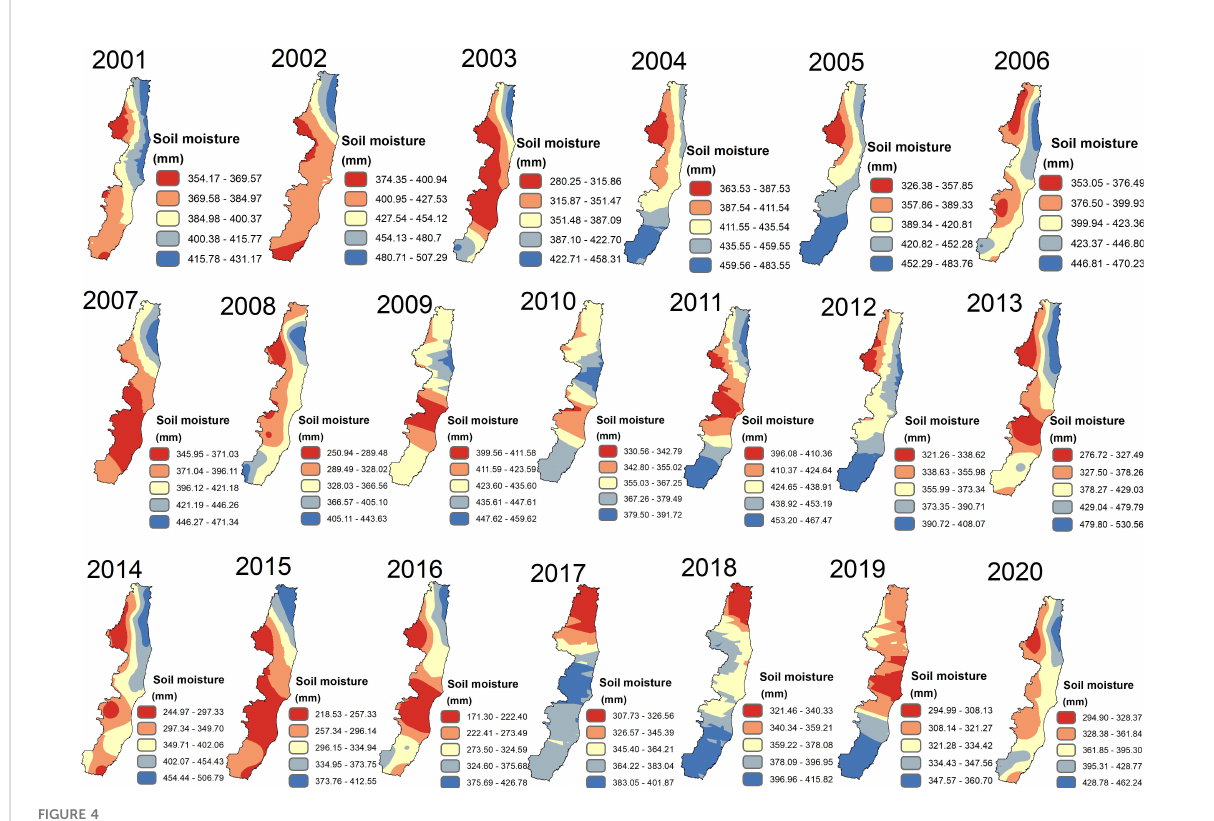
FIGURE 4 Spatiotemporal analysis of soil moisture in the Central Atlantic Forest Corridor,